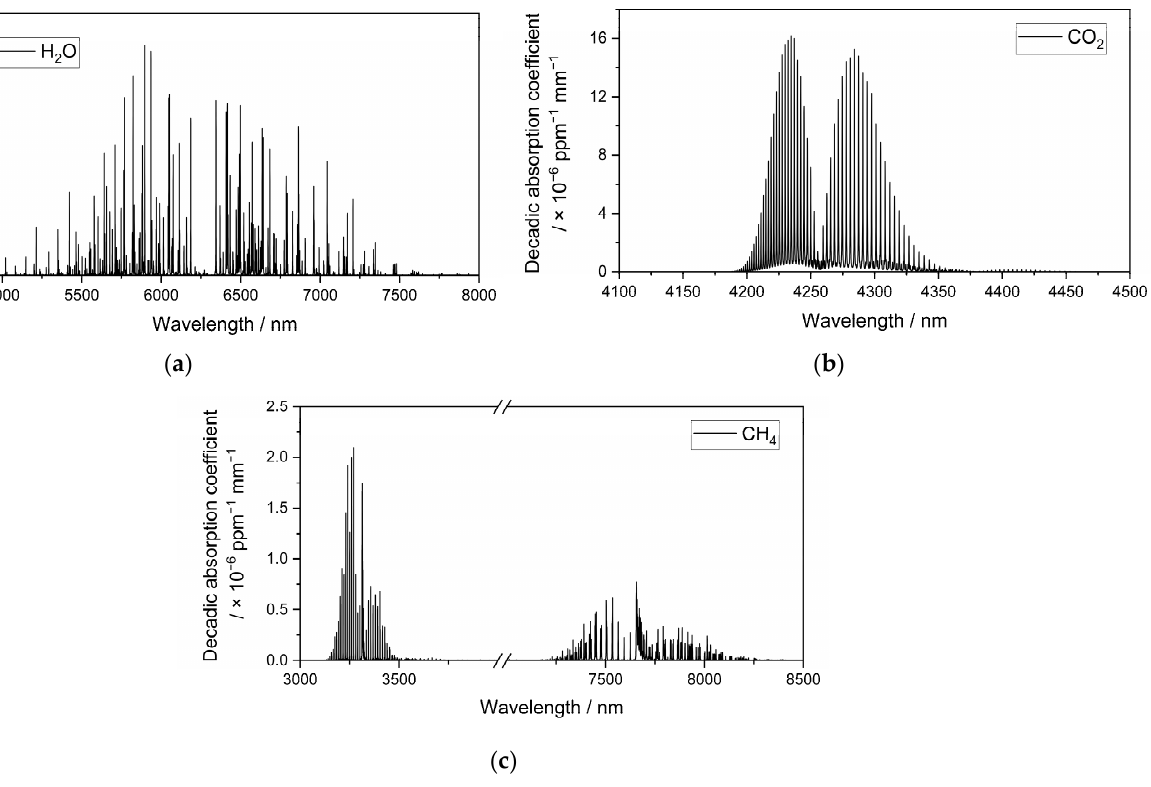
Figure 4. Decadic absorption coefficient spectra of ( a ) H 2 O between 4500 and 8000 nm, ( b ) CO 2 between 4100 nm and 4500 nm, and ( c ) CH 4 between 3000 nm and 8500 nm in standard conditions, which were calculated and plotted using the HITRAN database [34].